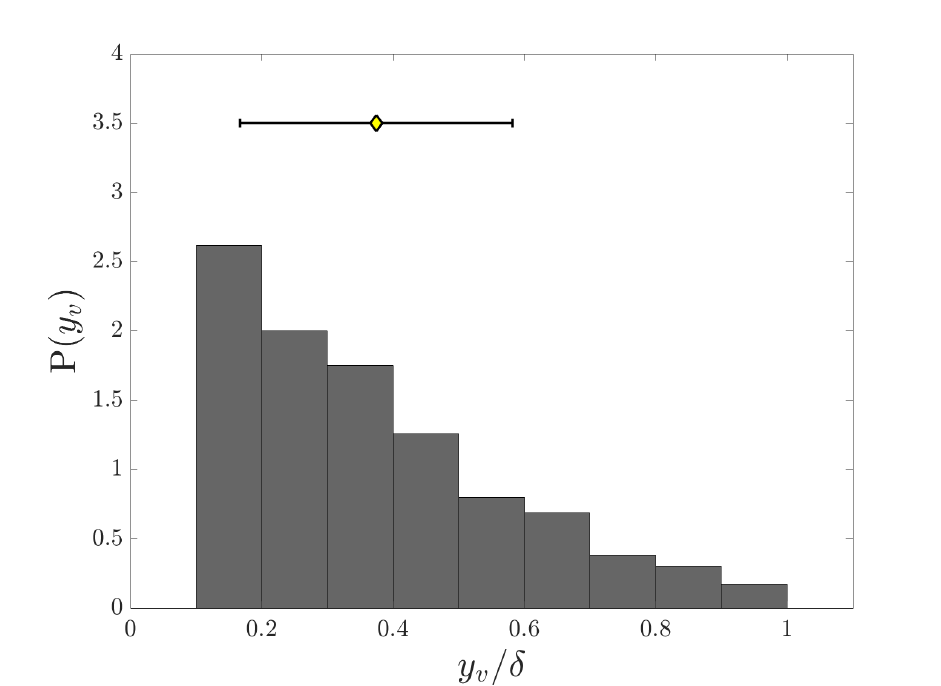
Figure A1. Probability Density Function P( y v / δ ) of the height of the vortices. The yellow diamond marker indicates the mean height of all vortices and the error-bar shows the standard deviation in the